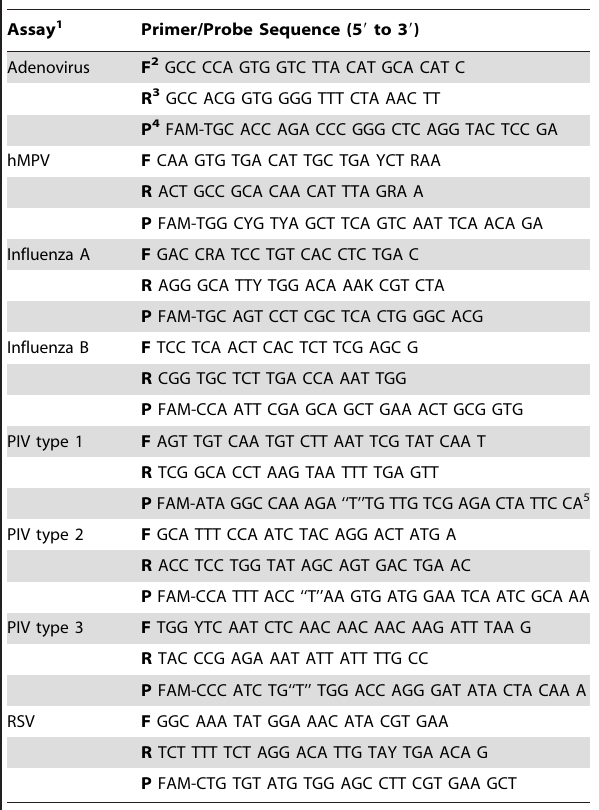
Table 2. Primers and probes used in this study. Assay 1